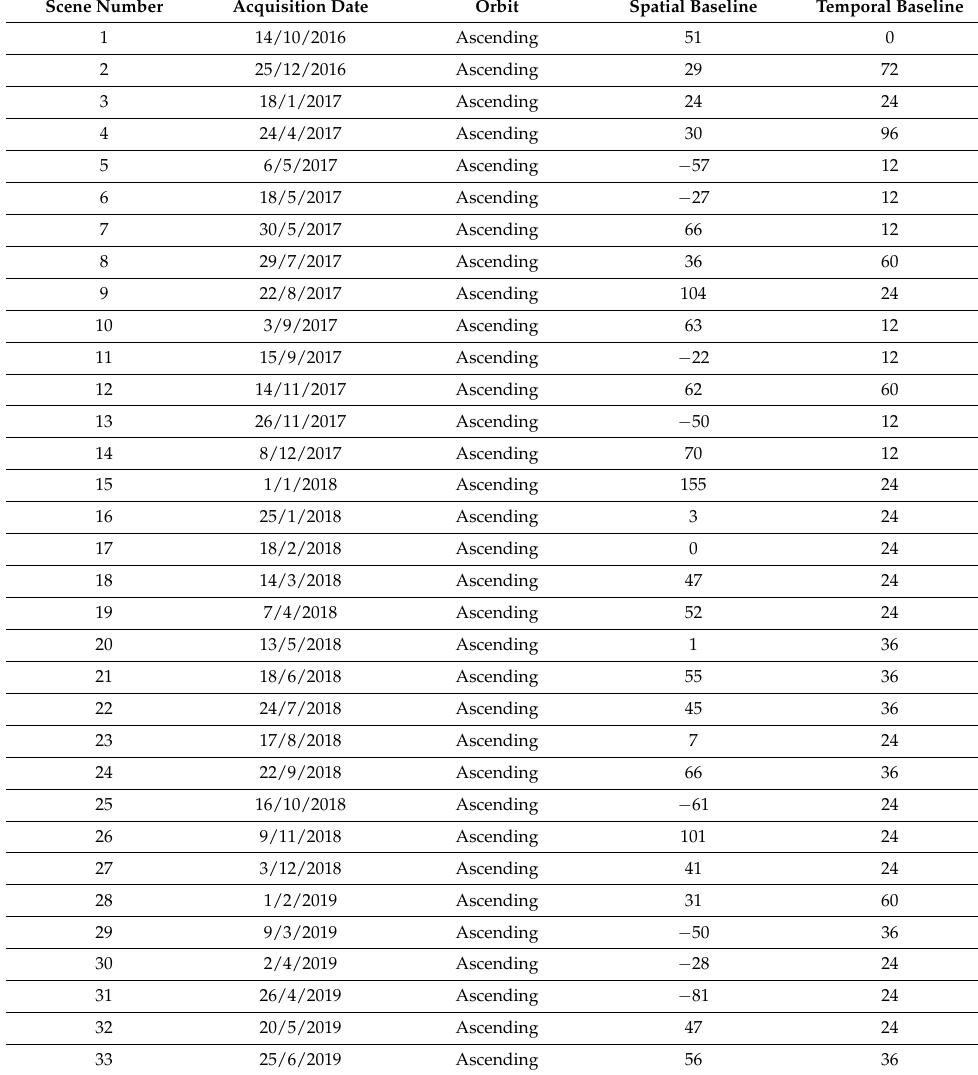
Table A2. List of SAR scenes used in the northern stack for subsidence mapping.